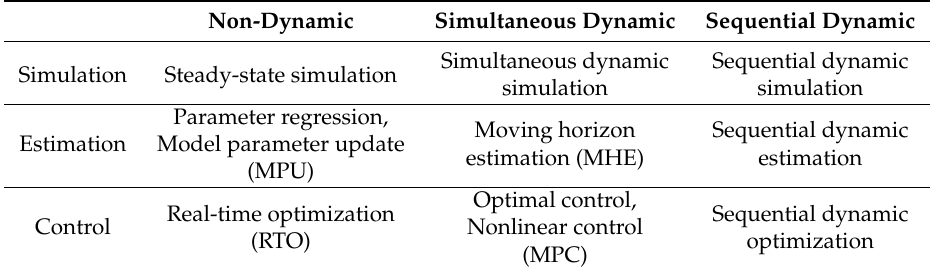
Table 1. Modes of